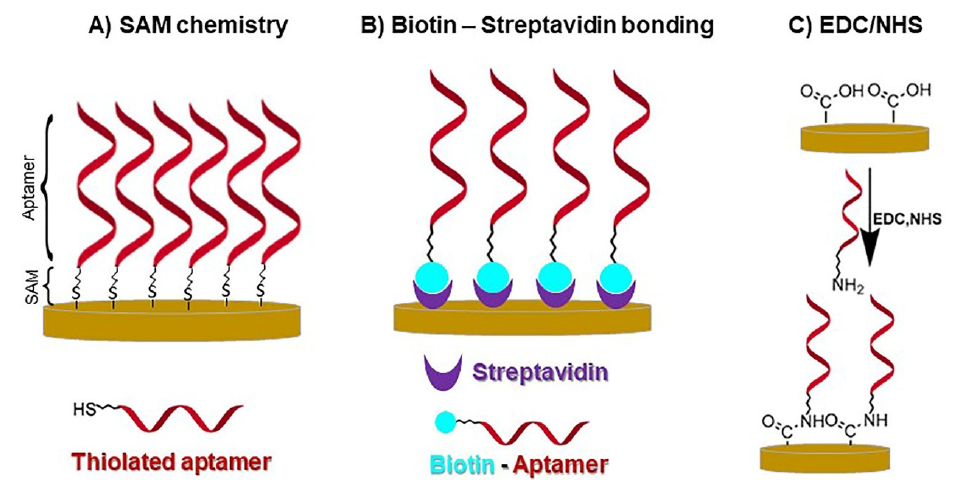
Figure 8. Schematics of the most common methods of surface immobilization for aptamers. ( A ) SAM chemistry, ( B ) biotin-streptavidin bond, and ( C ) EDC/NHS.